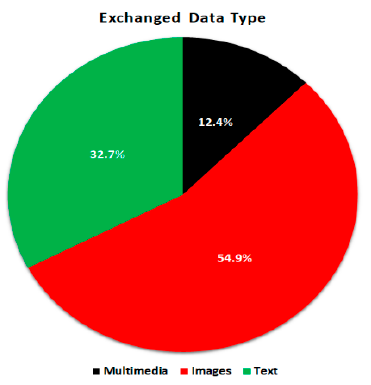
Figure 14. Percentage of each exchanged data type.